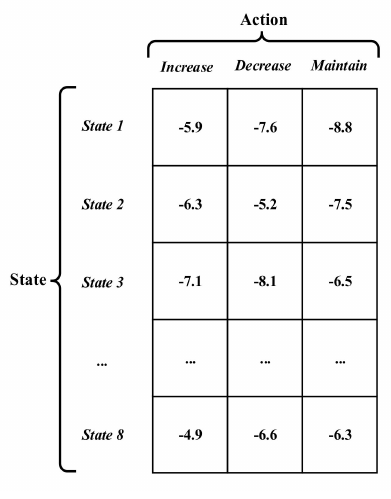
Figure 4. The form of